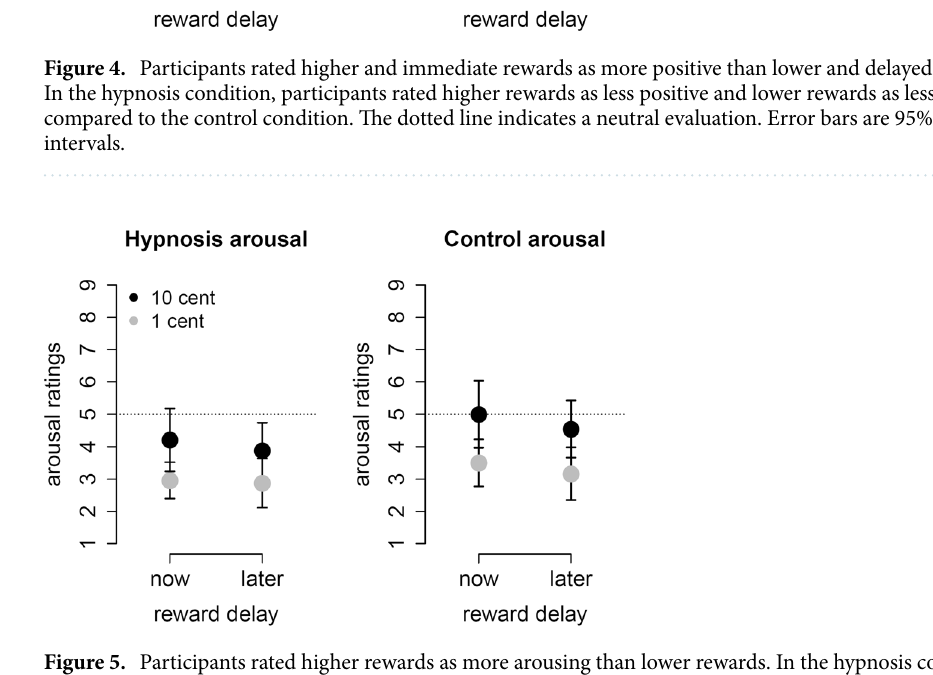
Figure 5. Participants rated higher rewards as more arousing than lower rewards. In the hypnosis condition, participants rated all rewards as less arousing than in the control condition. The dotted line indicates a neutral evaluation. Error bars are 95% confidence